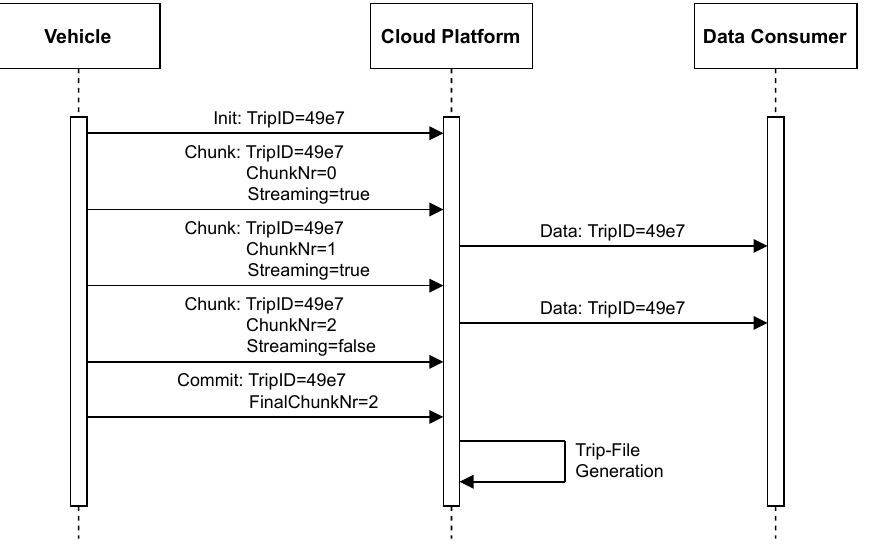
Figure 4. Transmission of a chunked trip